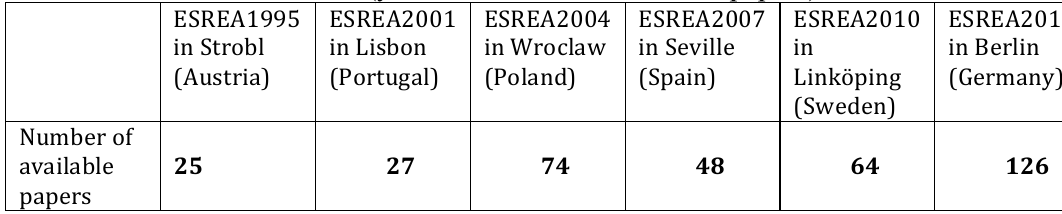
Table 1 : ESREA conferences (year, location and number of